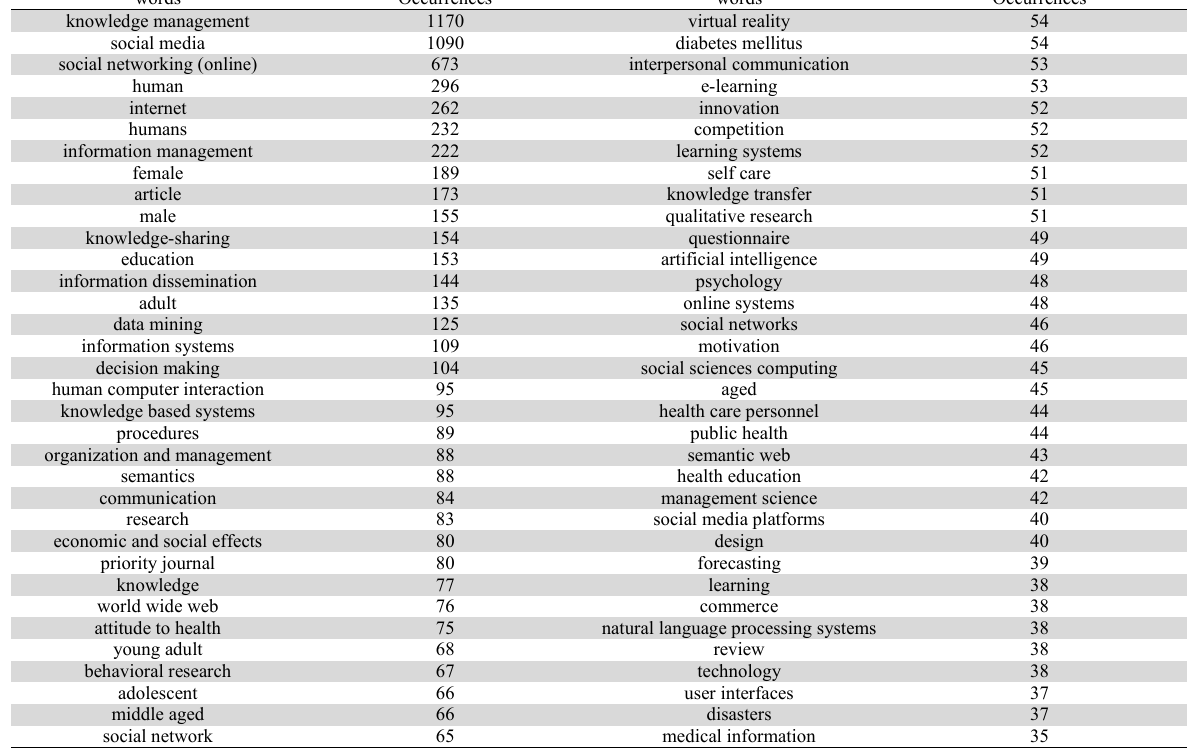
Occurrences words Occurrences